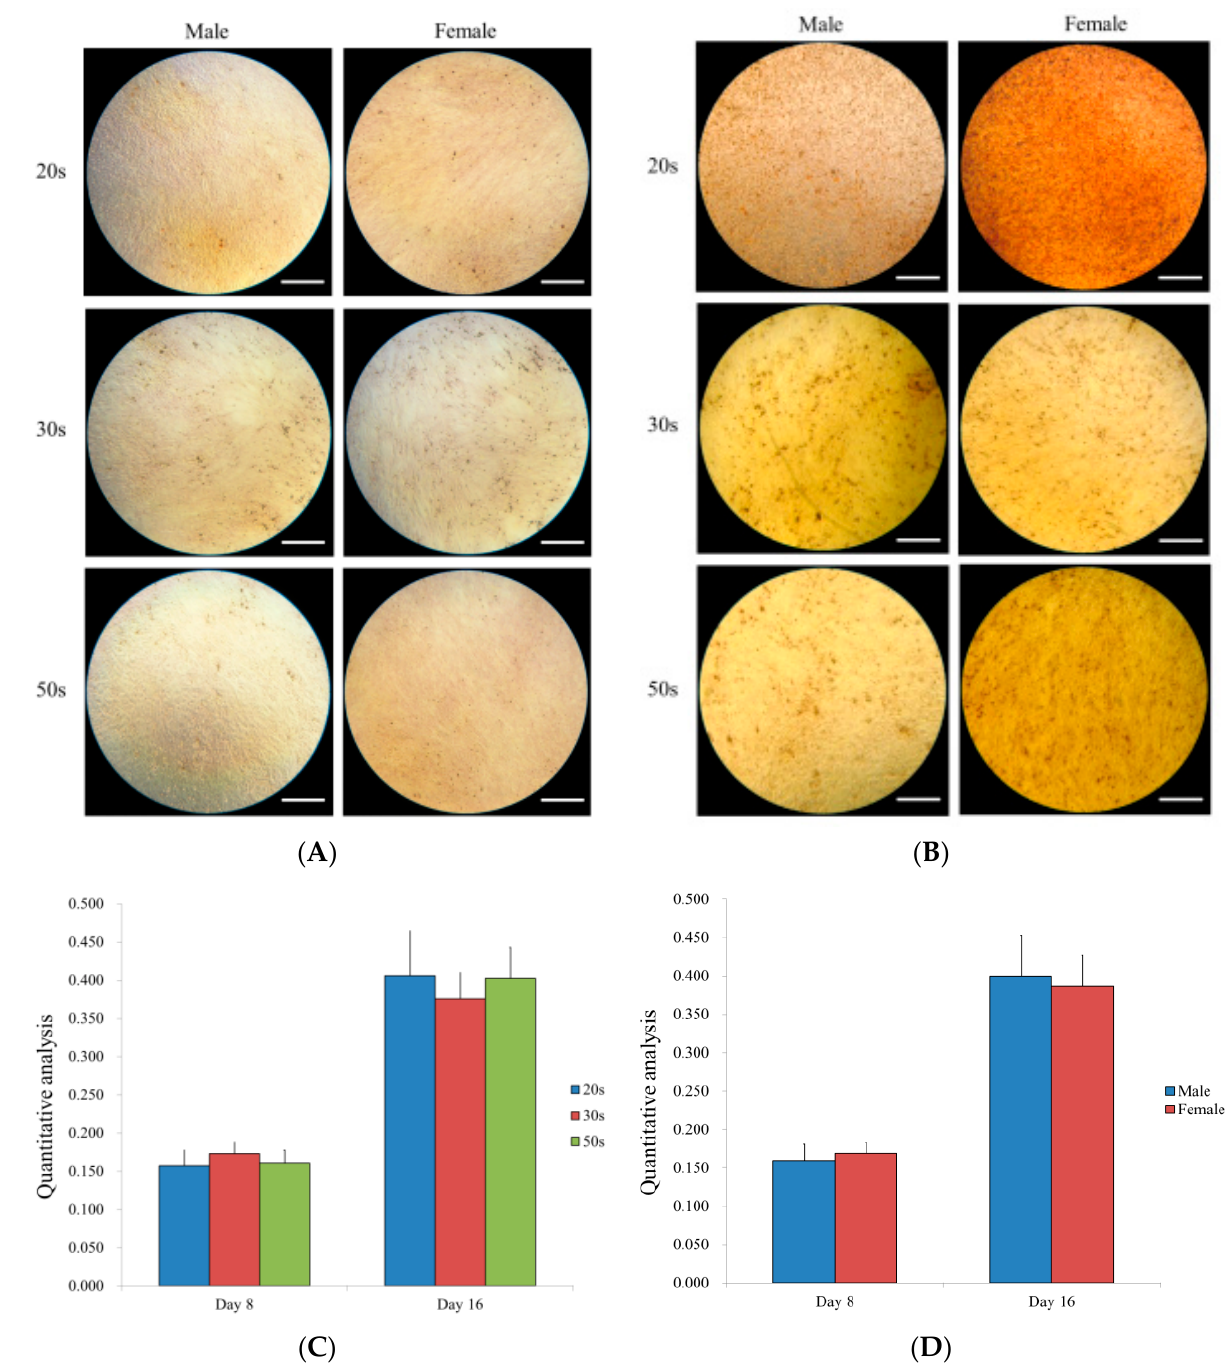
Figure 7. ( A ) Results of alizarin red S staining on Day 8 (original magnification 100 × ). The scale bar indicates 400 µ m. ( B ) Results of alizarin red S staining on Day 16. The scale bar indicates 400 µ m. ( C ) Quantitative results of the mineralization assay on Days 8 and 16 among the different age groups. ( D ) Quantitative results of the mineralization assay on Days 8 and 16 by